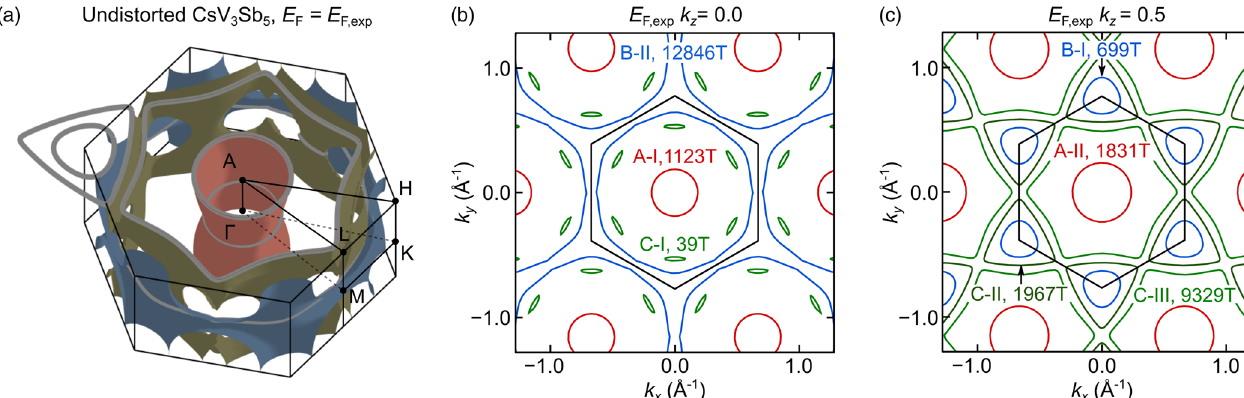
E FIG. 7. (a) Fermi surface for undistorted CsV 3 Sb 5 calculated with E F; exp , which shows a variety of potential orbits. Orbits F ¼ calculated with the SERENDIPITY PYTHON package are shown highlighted in gray. For clarity, in panels (b) and (c), we show isoenergy E contours at k z ¼ 0 and k z ¼ 0 . 5 for the E F; exp surface with all unique extremal orbits marked. Several high- and low-frequency F ¼ orbits can be identified. The Fermi surface pocket of origin is indicated through the orbit color, which will be used for comparison throughout our discussion. While there are clearly multiple frequencies in the predicted spectrum, note that there is only one symmetry unique (39 T) low-frequency mode, which is at odds with our experimental observations. Further, for frequencies 400 < f < 2000 T, there are only four predicted modes, as opposed to the five experimentally observed